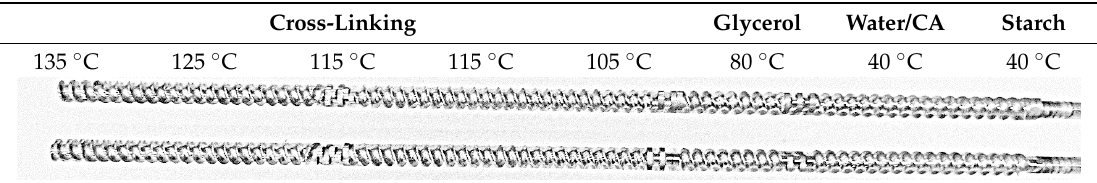
Table 3. Screw configuration and temperature profile. The screws were organized to allow longer permanence of starch into the cross-linking heating blocks. The numbers represents the heating and feeding blocks configuration temperatures.